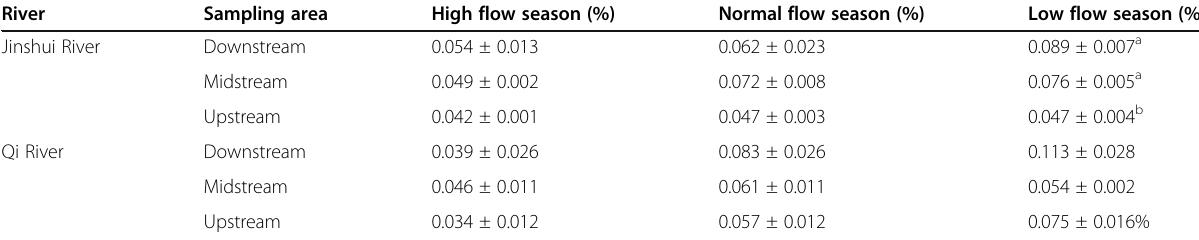
Table 3 N 2 O emission factor (EF5-r, dissolved N 2 O-N:NO 3 − -N) of Jinshui River and Qi River